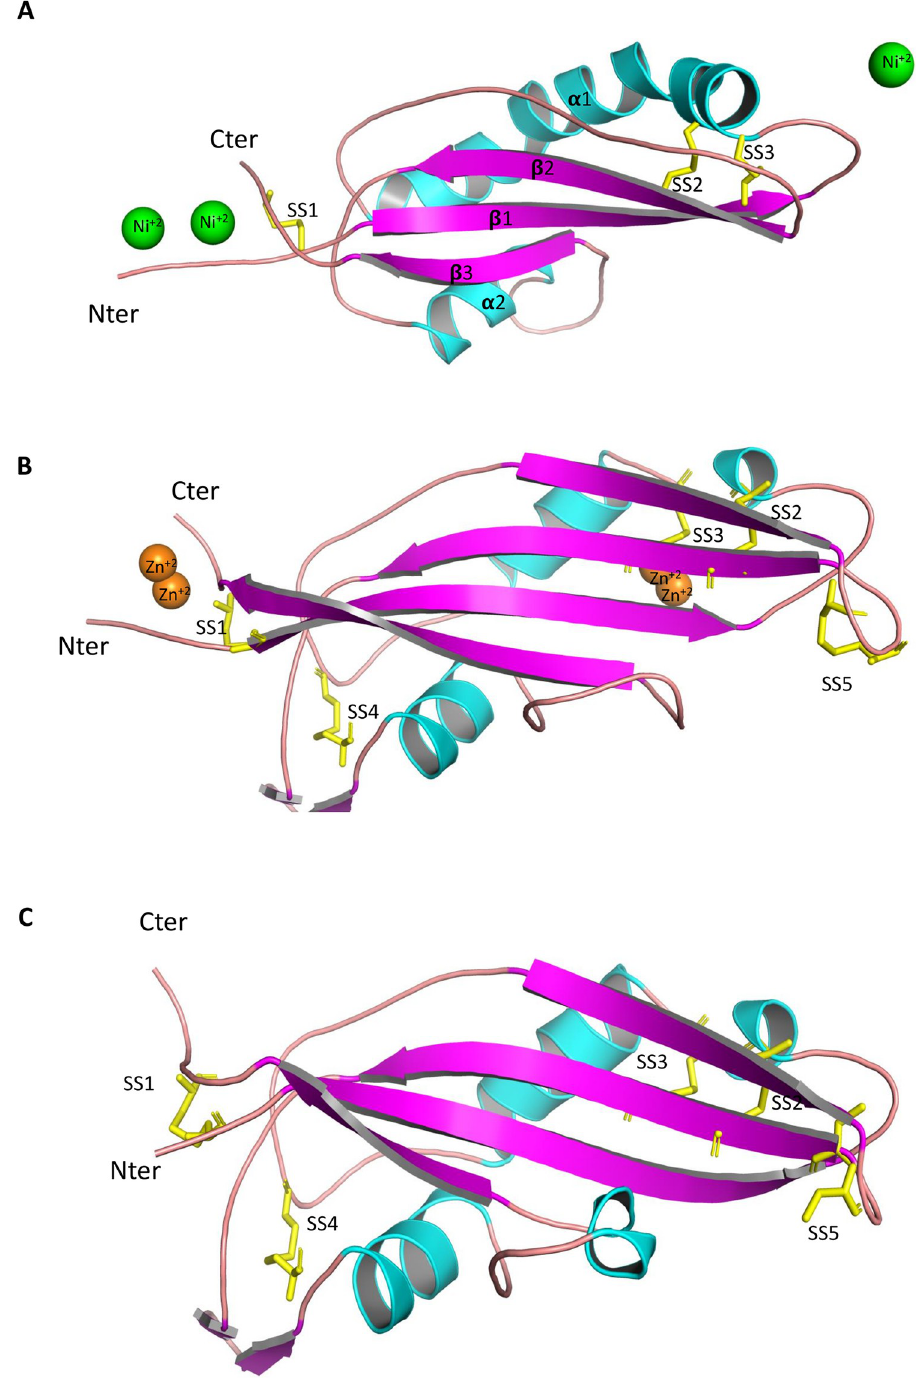
Fig 1. Crystal structures of AvrLm5-9 and Ecp11-1 and a 3D-model of AvrLm3. The proteins are represented as cartoons and coloured by secondary structure ( α -helix in cyan, β -strand in magenta). N- and C-termini are labelled. The S-S bonds are represented by yellow sticks, and are numbered (numbering refers to sequence alignment in Fig 2A). (A) Structure of AvrLm5-9. Ni +2 ions involved in crystal packing are shown as green spheres. (B) Structure of ECP11-1. Zn +2 ions involved in crystal packing are shown as orange spheres. (C) Swiss-Model structure of AvrLm3. The AvrLm3 amino acid sequence and the Ecp11-1 X-ray structure were used to compute the AvrLm3 three- dimensional